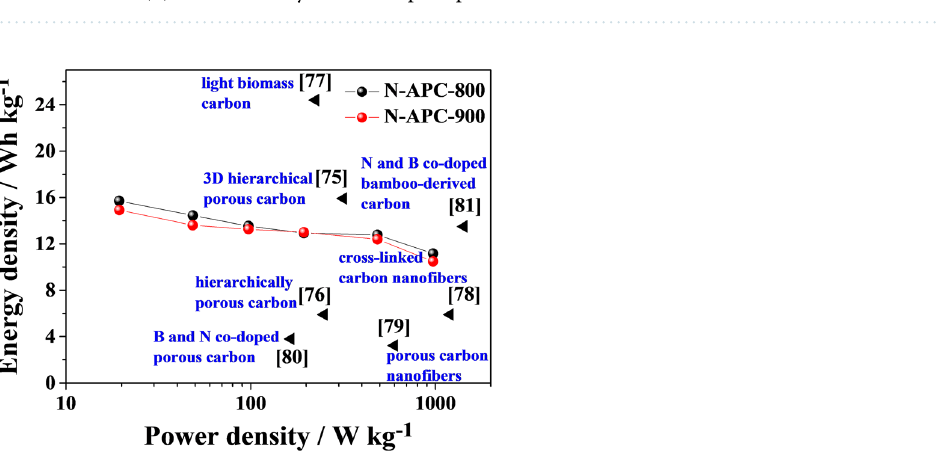
Figure 6. Curves of specific capacitance plotted as a function of cycle number for ( a ) N-APC-800 and ( b ) N-APC-900. Insets: exemplary galvanostatic charge–discharge curves for the electrode materials recorded at 5 A g −1 . Specific capacity as a function of the current density applied in charge–discharge measurements for ( c ) N-APC-800 and ( d ) N-APC-900 symmetric supercapacitors.